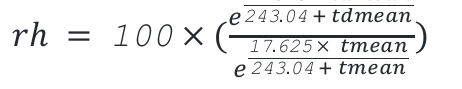
Figure 3 . Architecture Diagram for RINX (Harvard CGA.